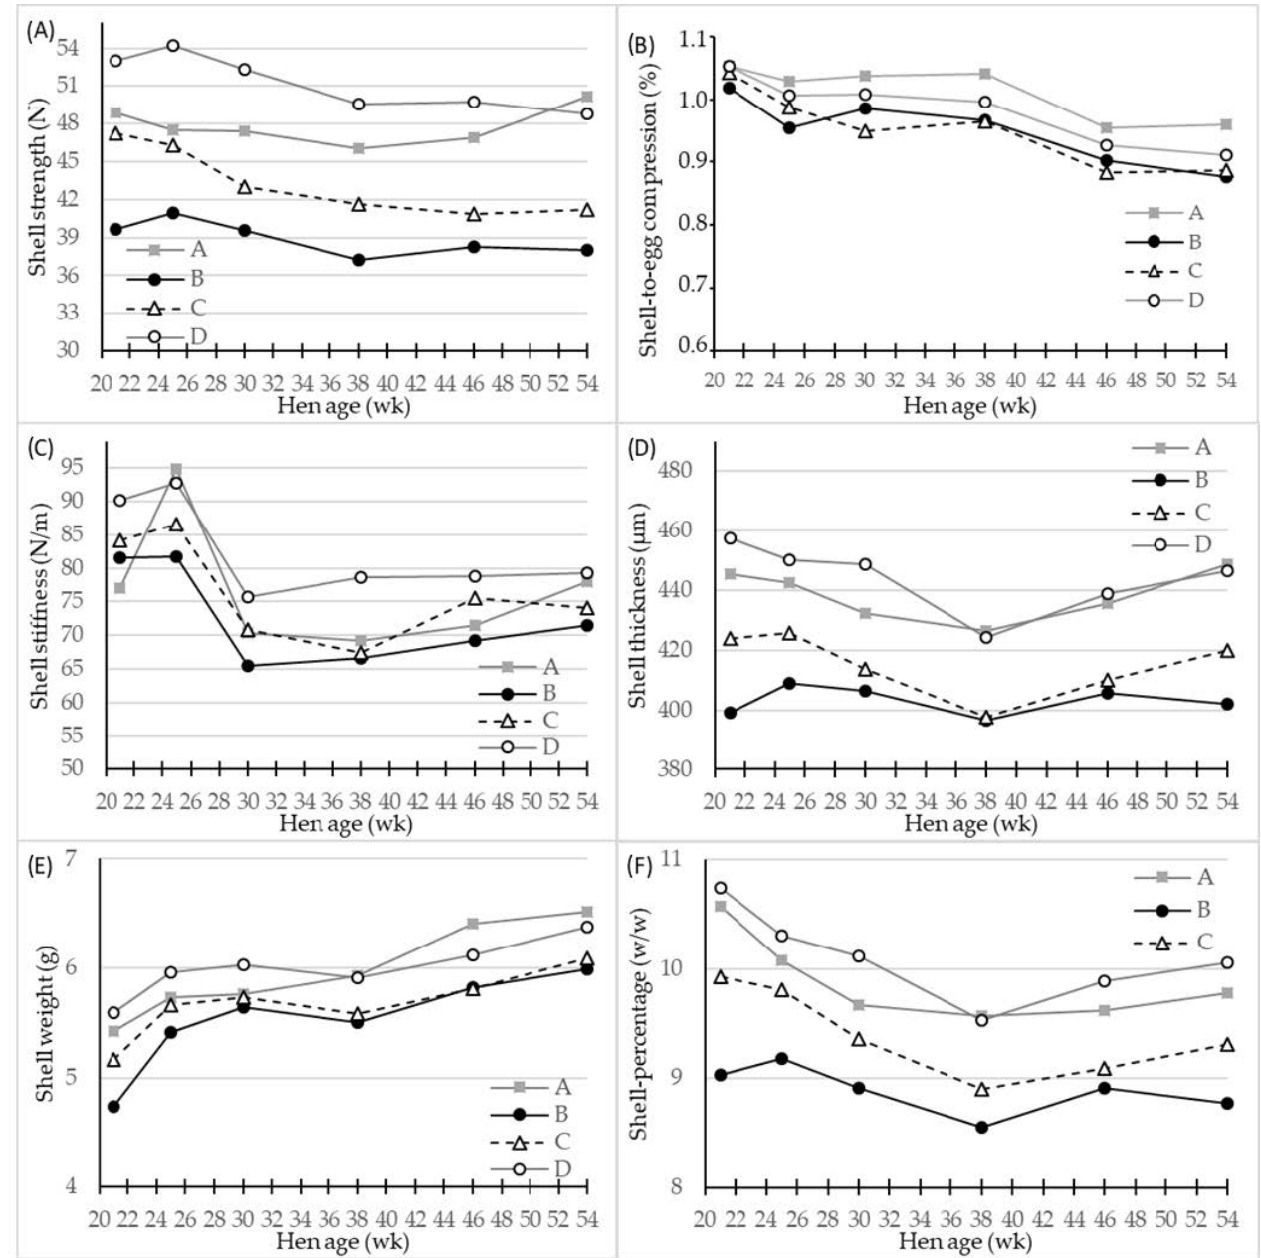
Figure 2. LS-means of shell parameters of four different hen genotypes ( A – D ) as differentiated by hen age (week). ( A ) shell strength (N) at compression, ( B ) shell-to-egg-compression (%), ( C ) shell stiffness (N/m), ( D ) shell thickness ( µ m) at equator, ( E ) shell weight (g) after air drying, and ( F ) shell percentage ( w / w ), n = 30 for genotype A and 45 for genotypes B, C and D.